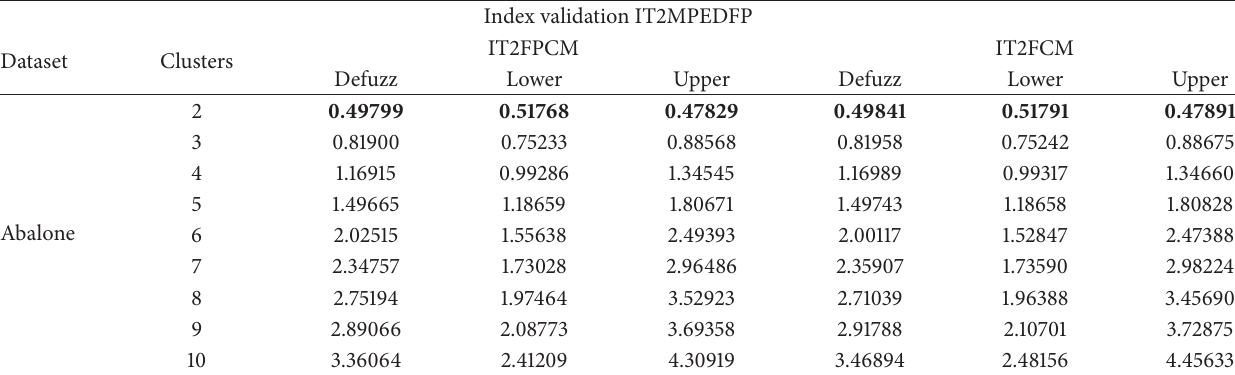
Table 17: IT2MPE-DMFP validation index results to Abalone dataset clustering using IT2FPCM and IT2FCM algorithm with 𝑚 = [1.5, 2.5] and 𝜂 = [1.5, 2.5] as parameters.